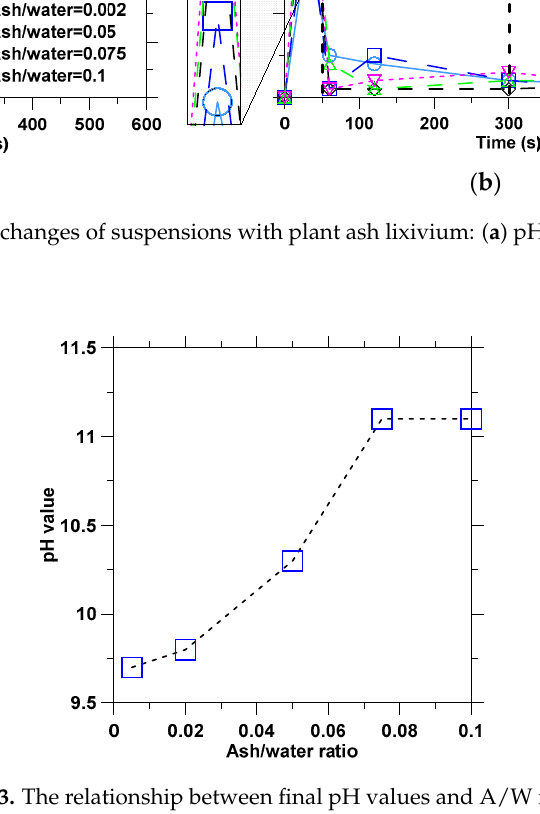
Figure 3. The relationship between final pH values and A/W ratios.